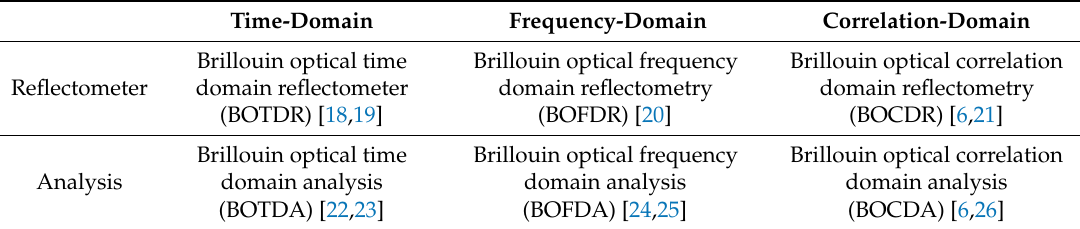
Table 1. Several Brillouin-based optical fiber sensing